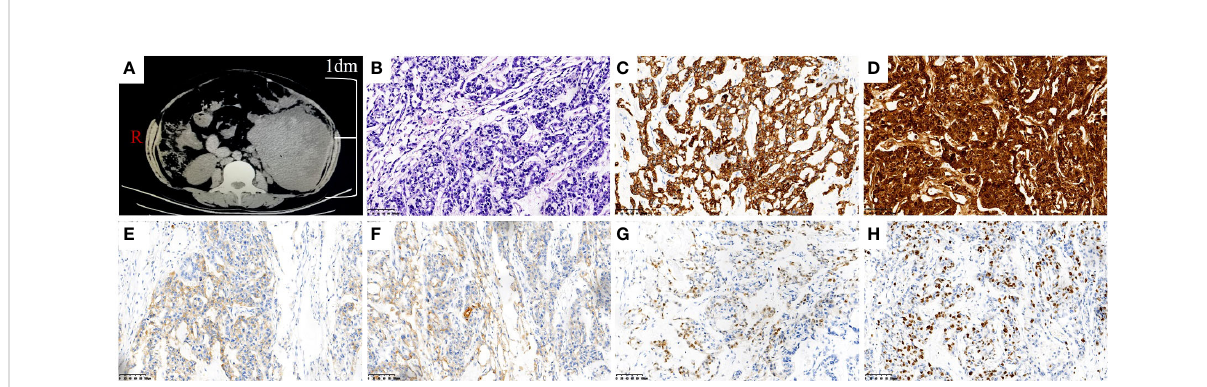
FIGURE 1 Image picture and pathologic images of mesenteric YST. (A) CT scan of mass in the left lower quadrant. (B) Hematoxylin-eosin staining of the mesenteric YST (×200). (C) Immunohistochemical staining of CK was strong positive(×200). (D) Immunohistochemical staining of AFP was strong positive(×200). (E) Immunohistochemical staining of CD117 was weakly positive (×200). (F) Immunohistochemical staining of PALP was weakly positive (×200). (G) Immunohistochemical staining of CDX2 was weakly positive (×200). (H) Immunohistochemical staining of Ki-67 was 50% positive